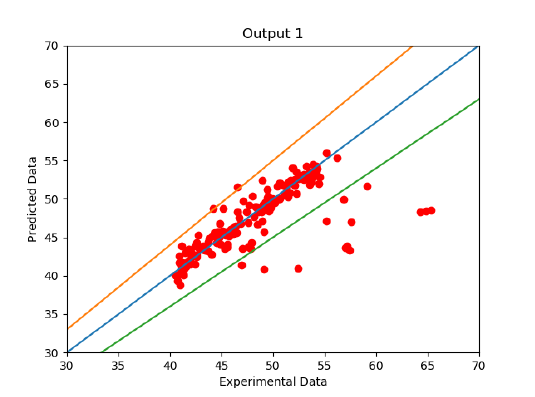
Figure 1. The plot of the predicted outlet temperature compared to the actual outlet